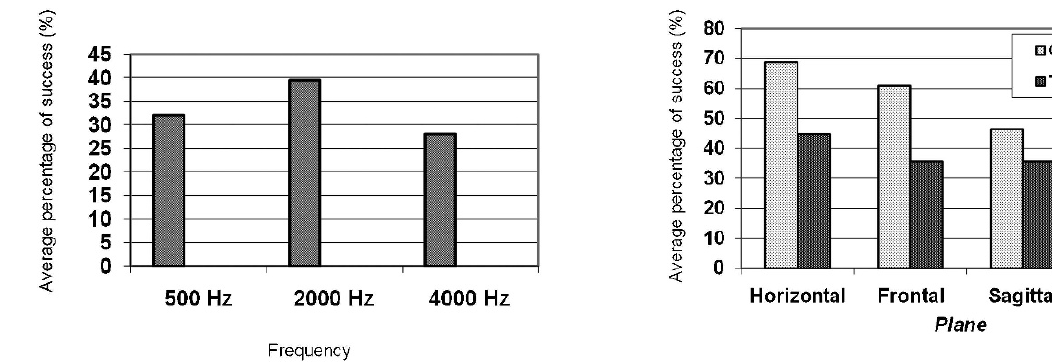
Figure 3 - A comparison of the average percentage of success between the groups according to plane.